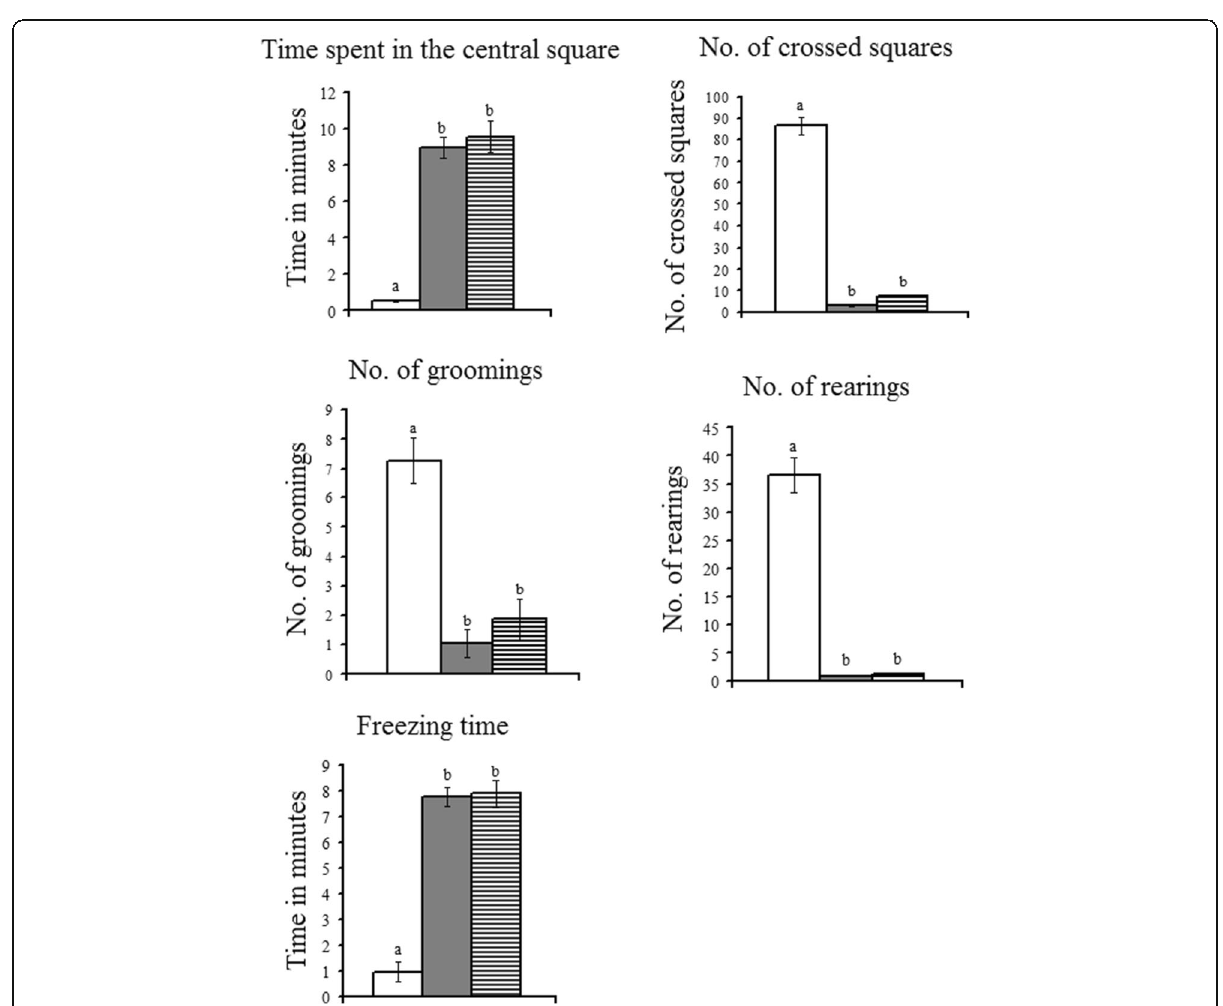
Fig. 1 Effect of daily caffeine treatment (30 mg/kg) on the open field test parameters in rat model of depression induced by reserpine. control. rat model of